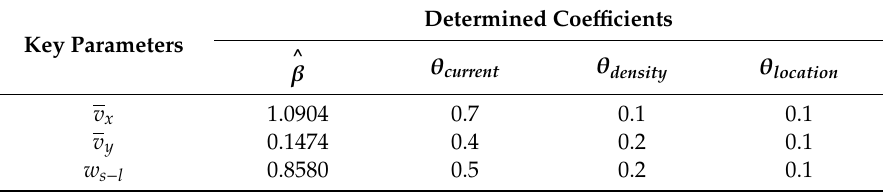
Table 2. Coe ffi cients of each key parameter for the Kriging model.